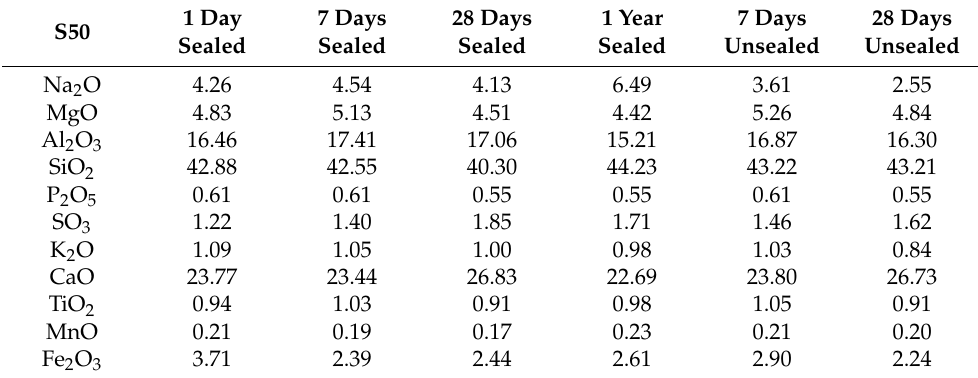
Table 11. Bulk chemistry obtained with PARC for the paste